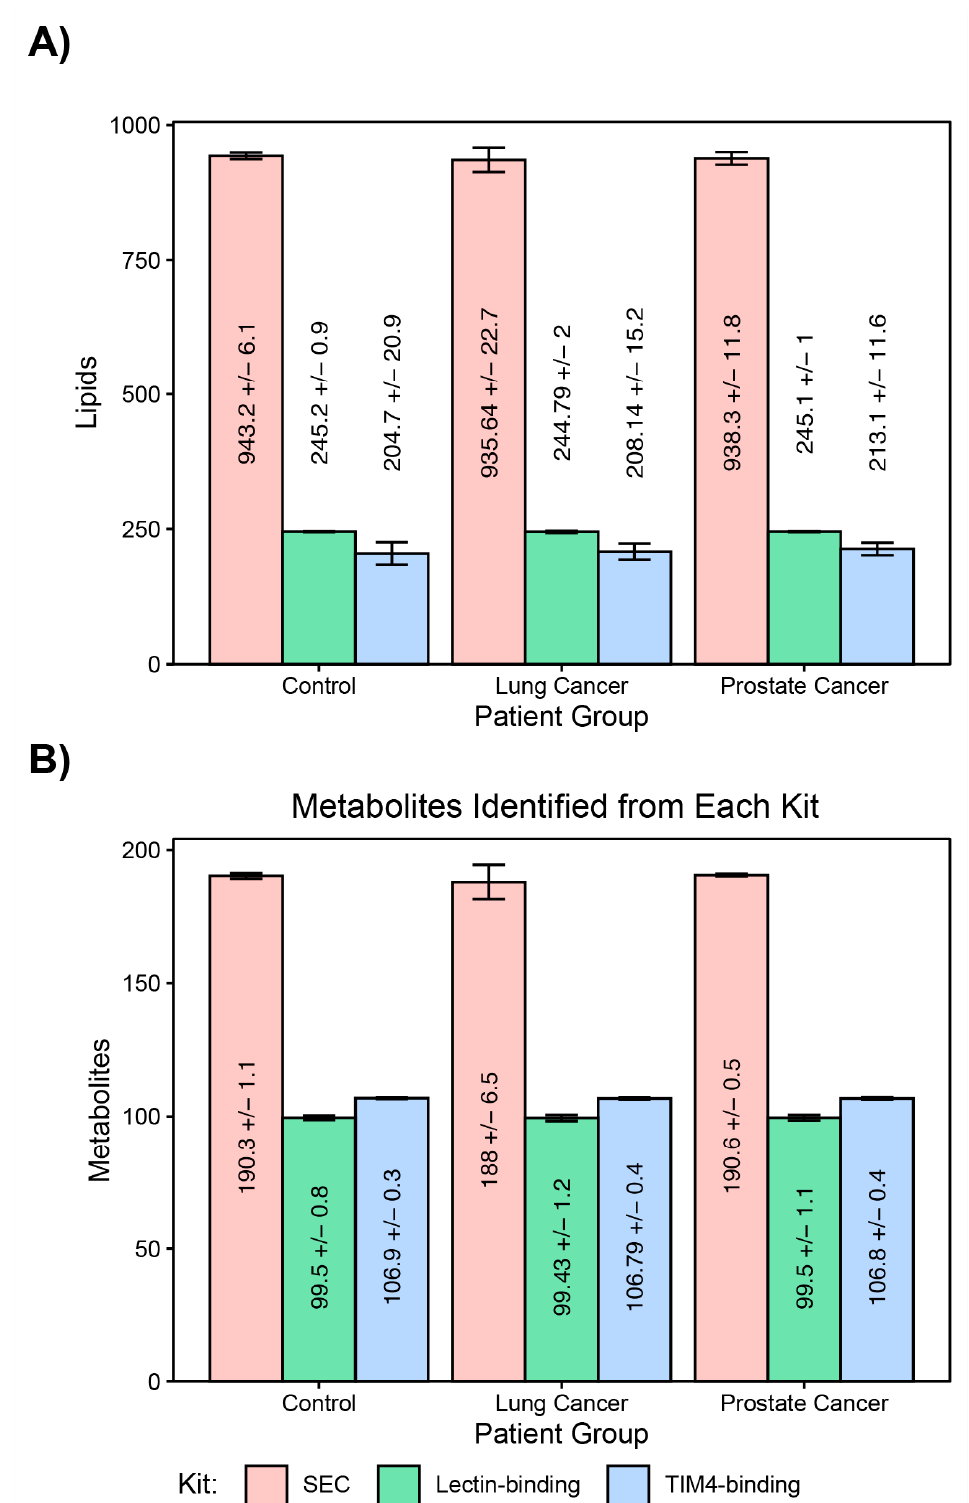
Figure 2. Average number of uniquely identified lipid ( A ) and metabolite ( B ) peaks from 3 exosome extraction methods.